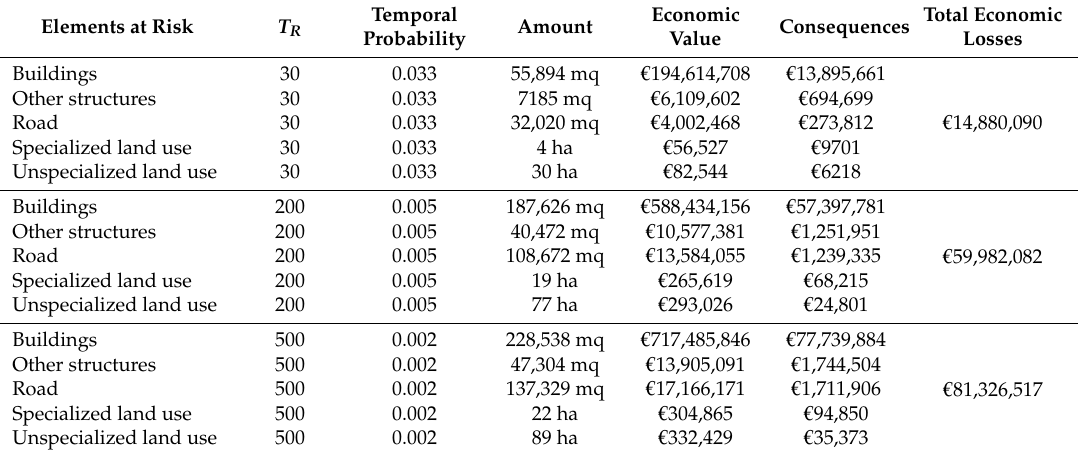
Figure 8. Risk curves for the main basin and sub-basins. Table 4. Definition, for each element at risk category and flooding scenario, of amount, economic value of exposed assets, and overall